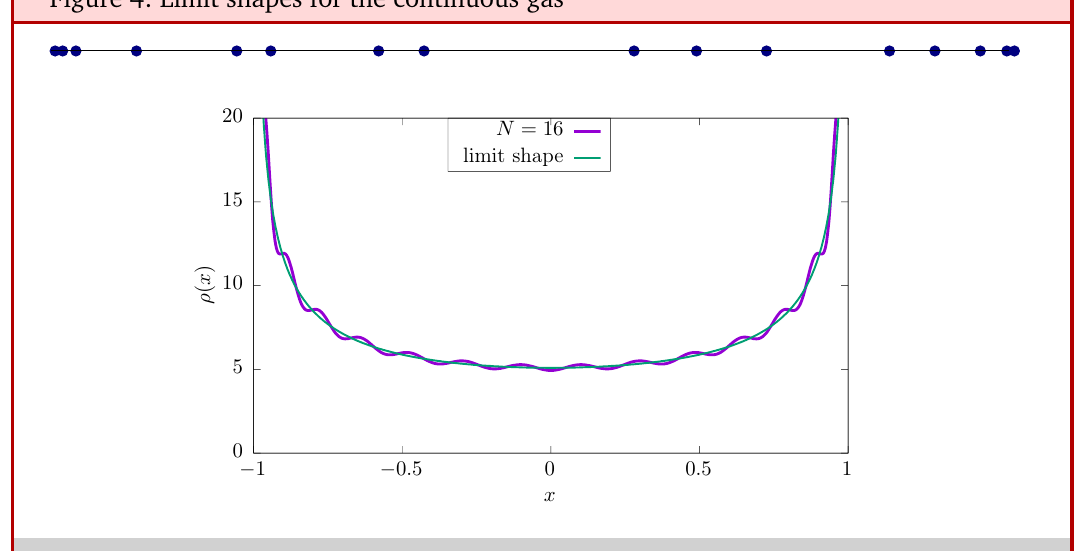
Figure 4: Limit shapes for the continuous gas